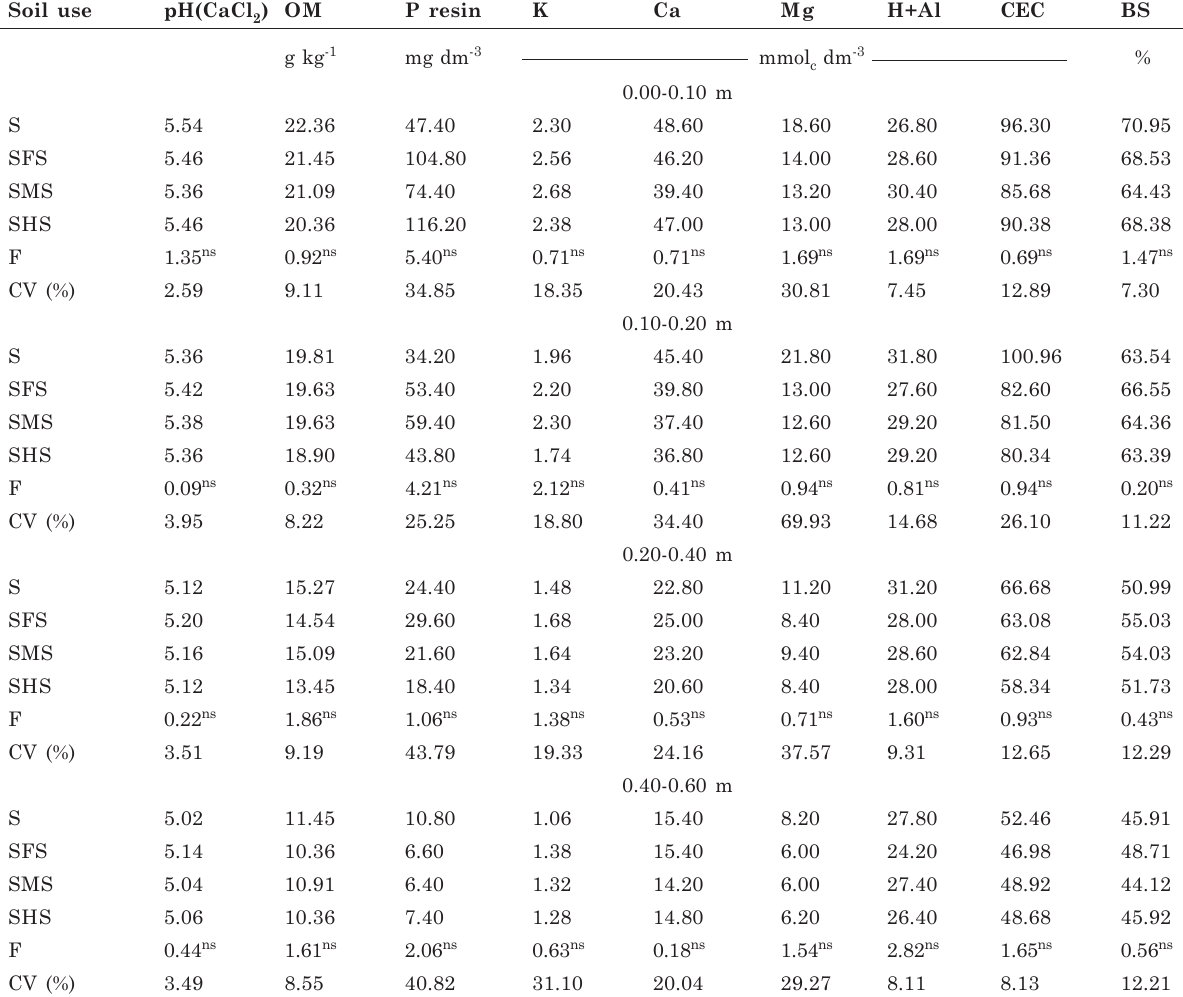
Table 2. Chemical properties of the acric Red Latosol after the first sugarcane